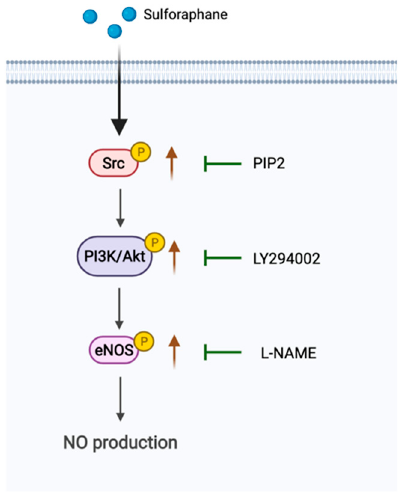
Figure 6. Proposed mechanism of action mediating sulforaphane-stimulated eNOS activation and NO production. SFN stimulates the activation of Src kinase that causes PI3 kinase activation, followed by Akt activation, which is an upstream kinase of eNOS and regulates eNOS activity by phosphorylation at Ser1177, ultimately leading to NO production.